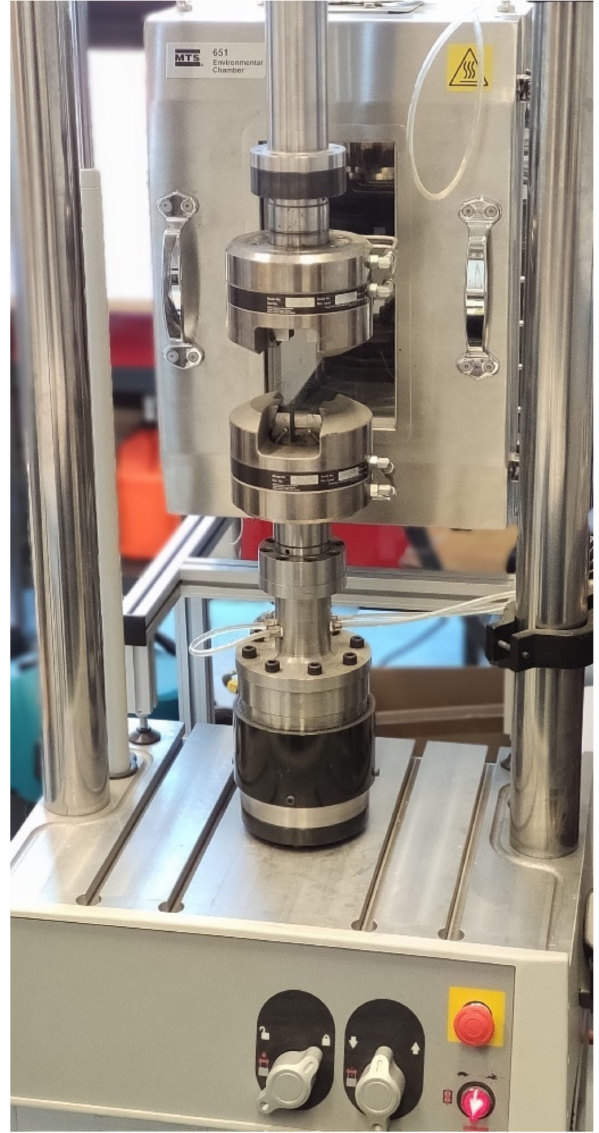
Figure 2. Test rig—MTS Bionix ® Servohydraulic Test